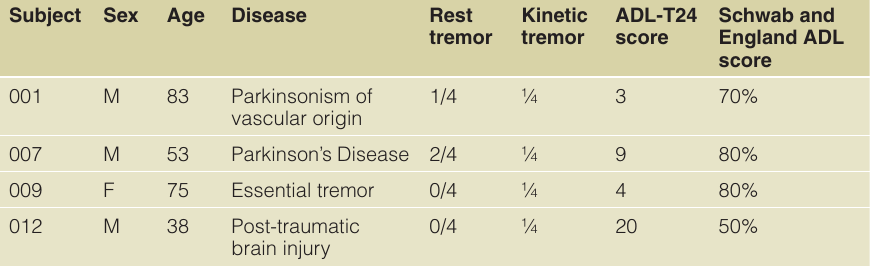
Table 1. Description of